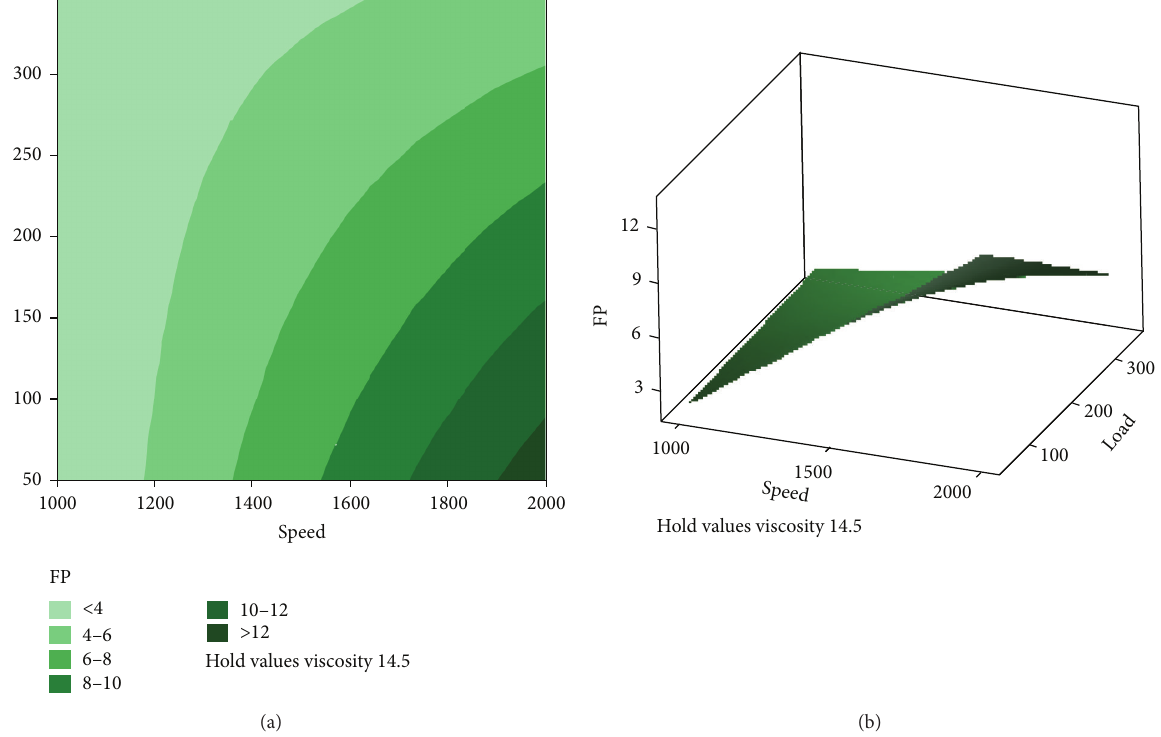
Figure 9: (a) Contour plot of FP versus load and speed at a viscosity of 14.5 cSt. (b) Response surface plot of FP versus load and speed at a viscosity of